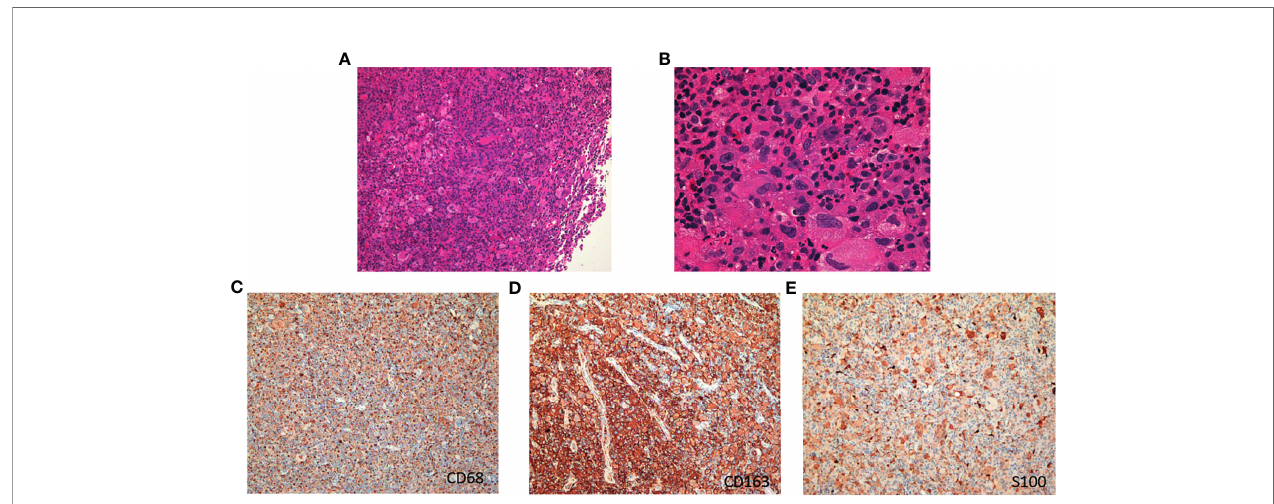
FIGURE 2 | The hematoxylin-eosin (H&E) and immunohistochemical pictures of the tumor. (A) H&E, original magni fi cation, ×100. (B) H&E, original magni fi cation, ×400. (C) Immunohistochemical staining for CD68. (D) Immunohistochemical staining for CD163. (E) Immunohistochemical staining for